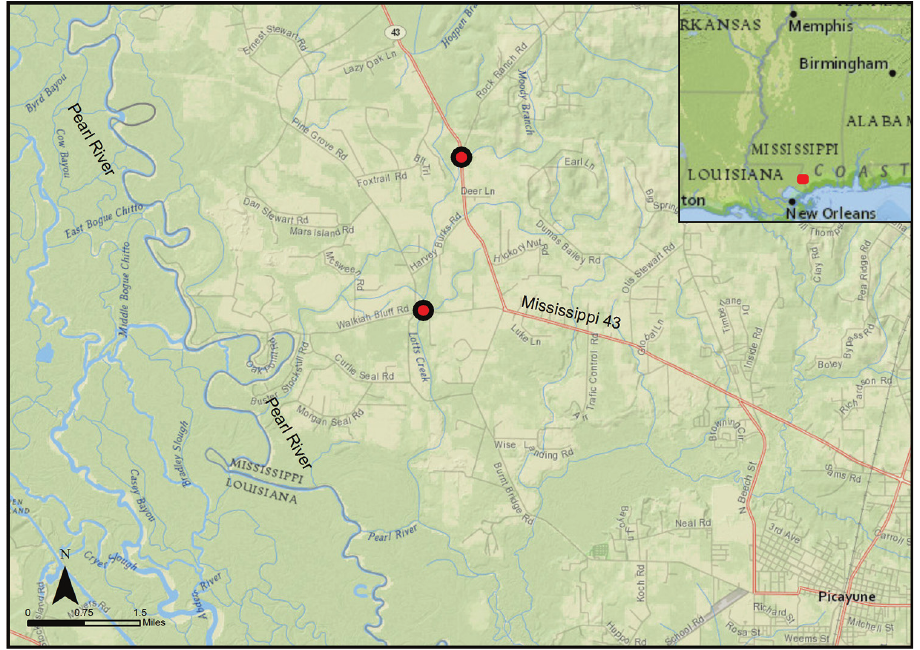
Figure 4. Map showing two localities of I. mississippiensis . Inset: Map of Mississippi with detail area highlighted. Map created using ArcGIS software